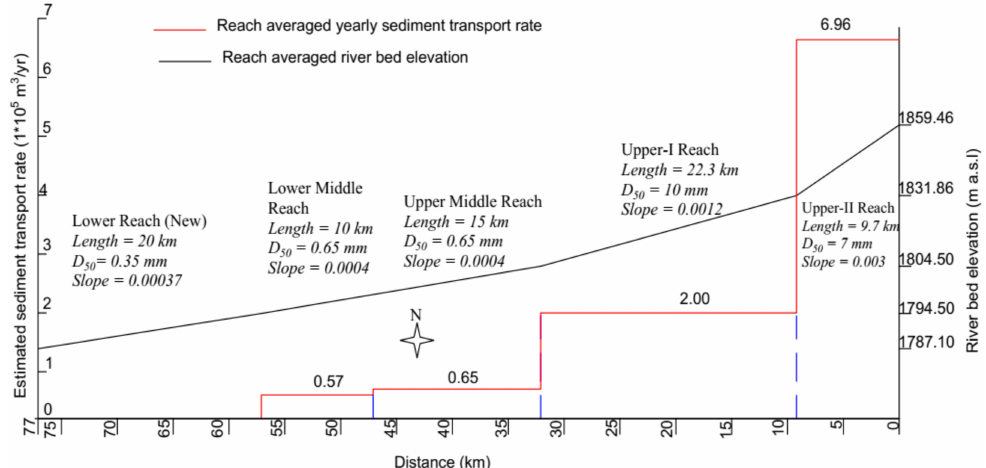
Figure 13. Sedimentation trend along the Ribb River based on estimated sediment transport rates. Distance of 0 km corresponds for dam site while 77 km is Lake